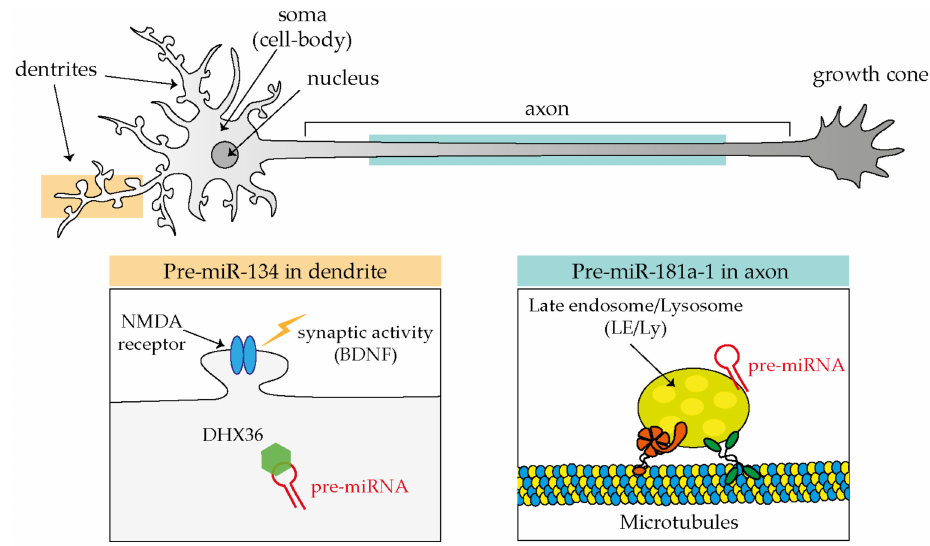
Figure 2. MiRNAs transport in neuronal compartments as inactive pre-miRNAs